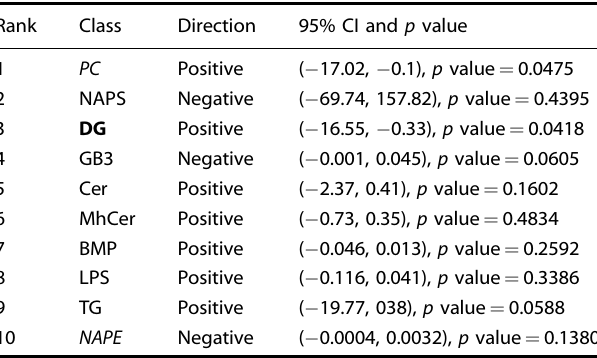
Table 1. Ten most contributing lipid classes to distinction between SNCA + /PD + and SNCA − /PD − .